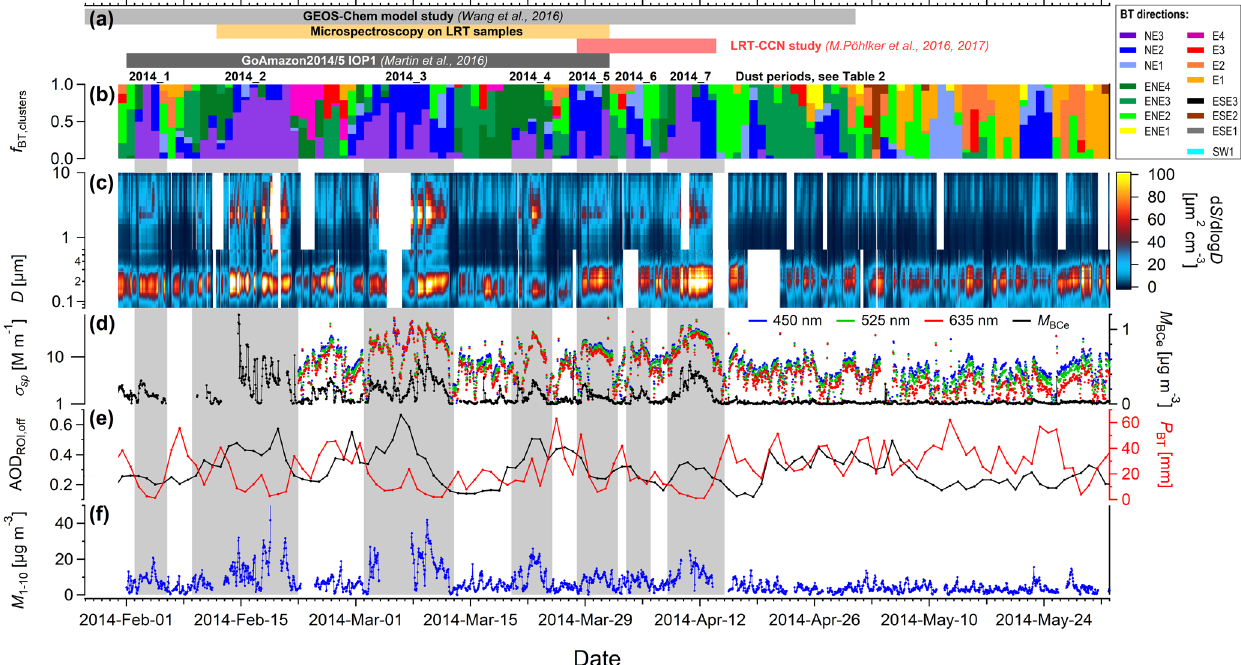
Figure 9. Meteorological and aerosol time series during the wet season 2014 case study. (a) Colored markers represent time periods of relevant intensive observation activities during 2014 case study. (b) Frequency of occurrence, f BT , clusters , of 15 back trajectory clusters as displayed in Fig. S4 (with identical color coding). (c) Image plot of aerosol surface size distribution for the size range from 80nm to 10µm. ( d , left axis) Time series of the aerosol scattering coefficients, σ sp , at three different wavelengths. ( d , right axis) Equivalent black carbon mass concentration, M BCe , calculated assuming a mass absorption cross Section MAC of 11.4m 2 g − 1 during the wet season. ( e , left axis) Satellite-retrieved aerosol optical depth at 550nm, area-averaged over offshore region of interest (ROI off , see Fig. S4). The AOD ROI , off time series represents the average of the MODIS data sets from the satellites Aqua and Terra. ( e , right axis) HYSPLIT-retrieved accumulated precipitation, P BT , along the trajectory tracks. (f) Aerosol mass concentrations in the coarse mode 1–10µm ( M 1–10 ). Time series represent hourly averages, except f BT , clusters , AOD ROI , off , and P BT . Gray vertical bands mark episodes when Saharan LRT aerosol was measured at the ATTO site (see Table 1). The f BT , clusters , AOD ROI , off , and P BT time series are shown as daily averages. The image plot of the aerosol size surface distribution as well as the σ sp , M BCe , and OPS mass concentrations time series are shown as daily